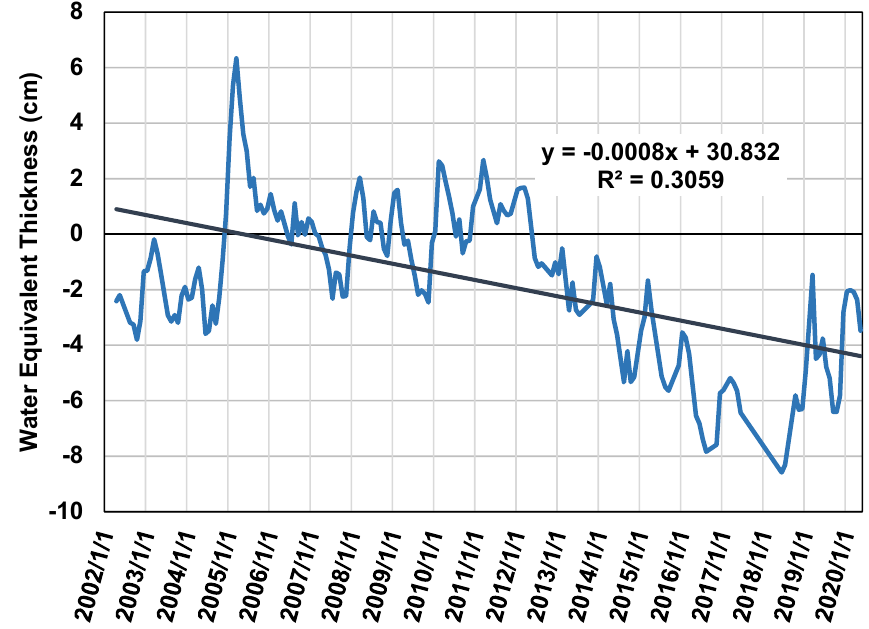
Figure 7. Change in water equivalent thickness 2002 to 2020. Gravity Recovery and Climate Experiment (GRACE) sensors provide monthly measurements of water equivalent thickness. This chart shows data for the pixel encompassing the area surrounding the study area. This information can be interpreted as a proxy for trends in ground water for our study area.